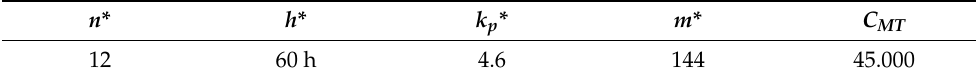
Table 14. Optimal control chart parameters.